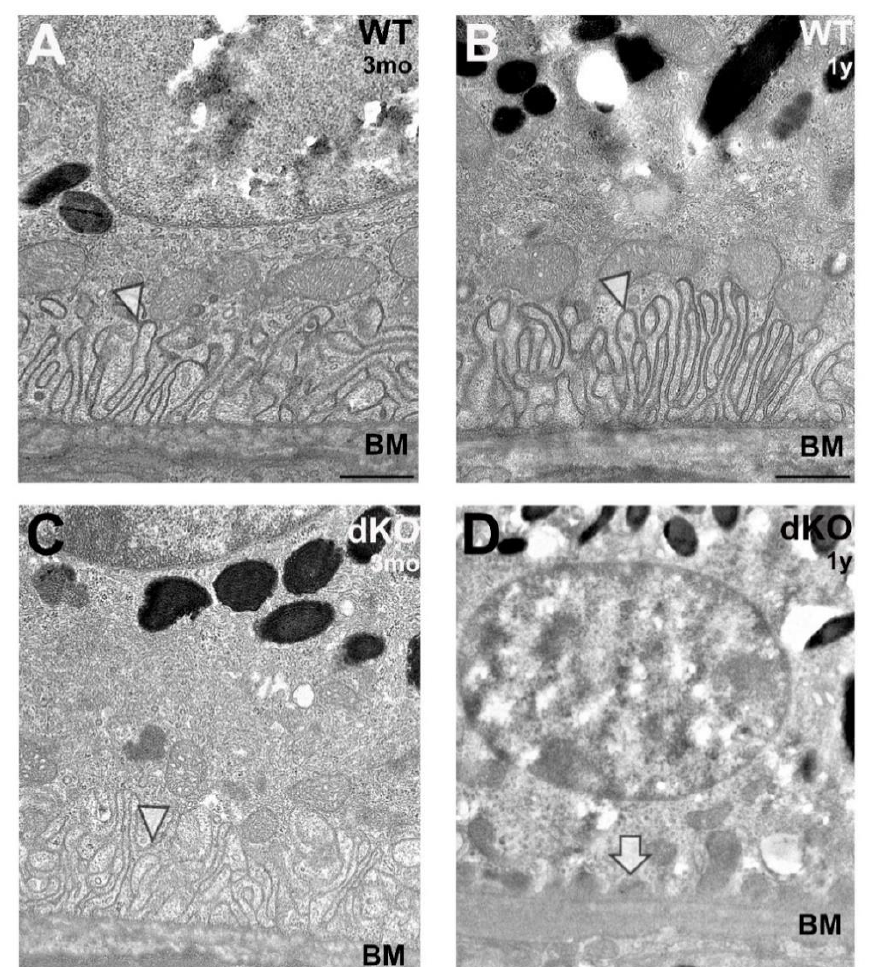
Figure 3. Structural changes of the basal compartment of the retinal pigment epithelium (RPE) in NFE2L2/PGC-1 α double knockout (dKO) mice as compared to their age-matched wild-type (WT) counterparts. Representative high power transmission electron microscopy (TEM) images of the samples of three-months- ( A , C ) and one-year-old ( B , D ) WT and dKO animals are shown. RPE of WT mice at both time points ( A , B ) and the three-months-old dKO samples ( C ) show normal basal arrangement: well-organized infoldings above Bruch’s membrane, supporting intracellular organelles (infoldings indicated by arrowheads) and typical thickness of Bruch’s membrane (BM). In contrast, many of the one-year-old NFE2L2/PGC-1 α dKO mice RPEs show ultrastructural signs of loss of the basal infoldings with basal linear deposits ( D ; arrow), resulting in unsupported intracellular organelles above Bruch’s membrane. Scale bars: 1 µm.